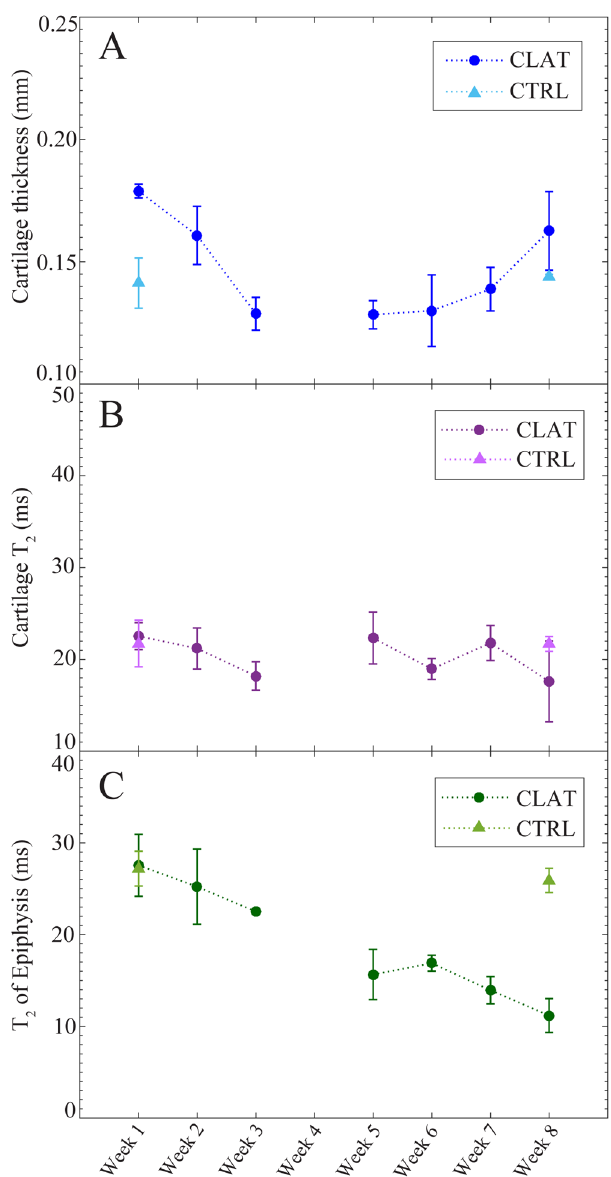
Figure 6. Changes in the tissues of the medial condyles of CLAT joints, in comparison to controls, during the eight week observation period post meniscectomy. Cartilage thickness ( A ), cartilage T 2 ( B ) and T 2 of epiphysis ( C ) of CTRL and CLAT joints are plotted for week 1–week 8 for central coronal slice location. Data plotted as mean ±